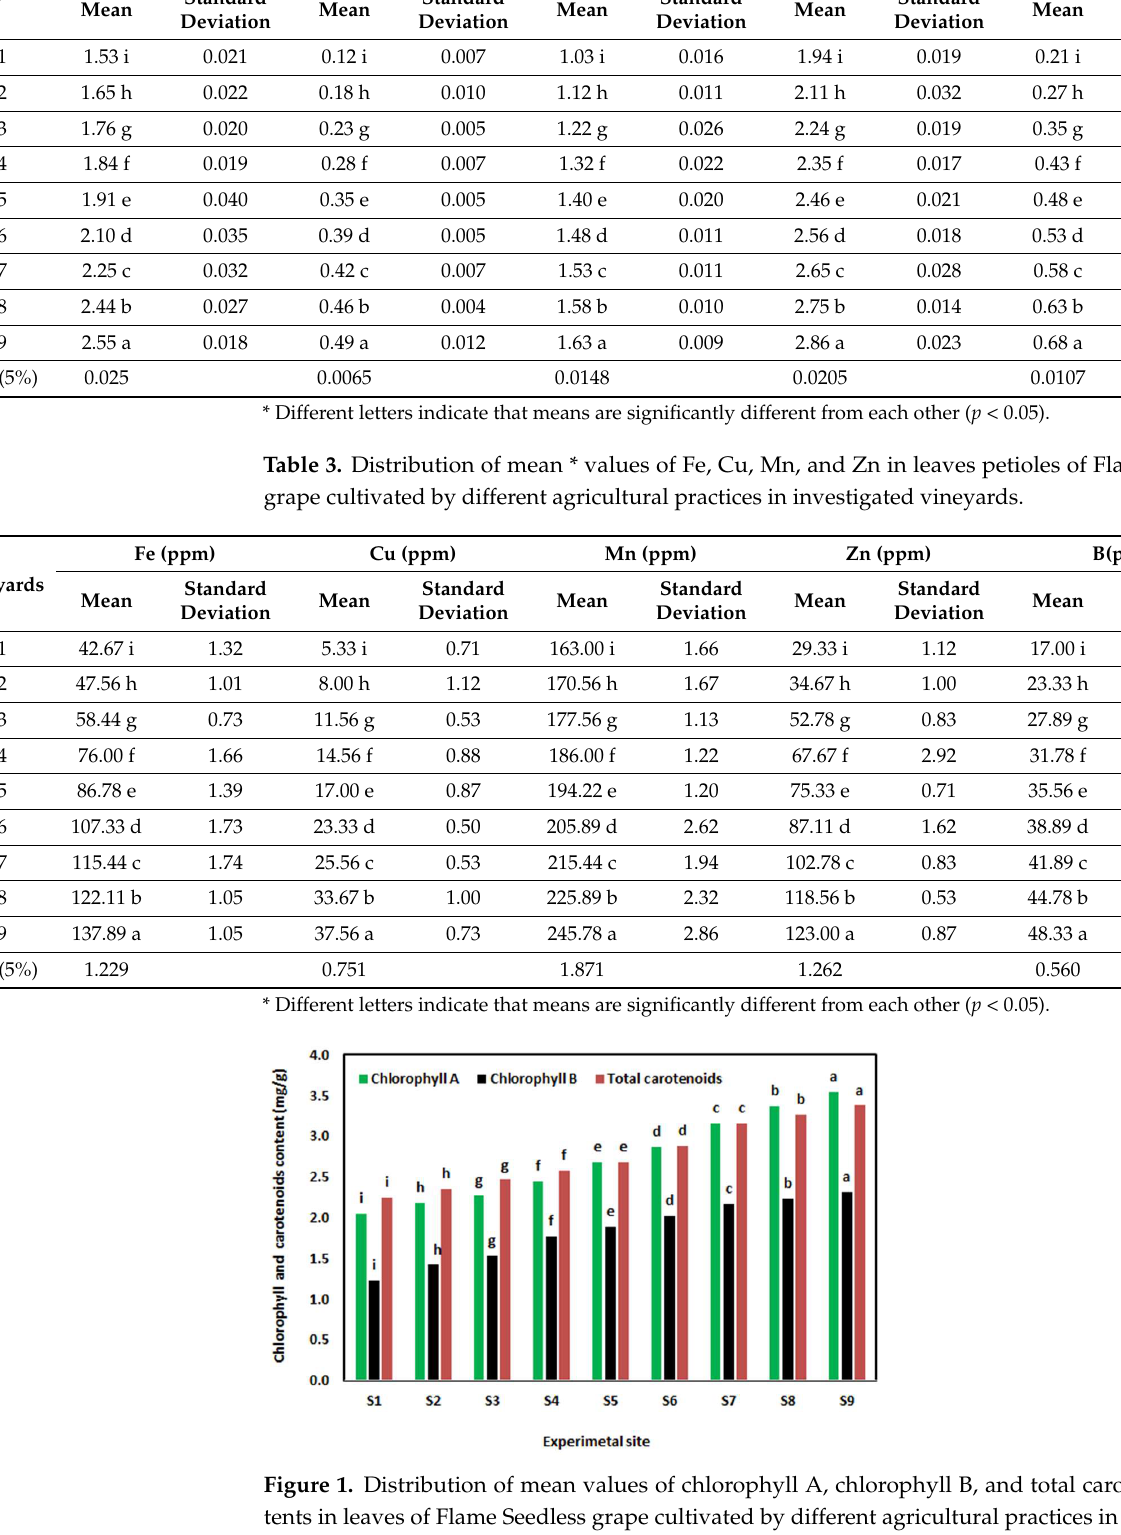
Table 2. Distribution of mean * values of N, P, K, Ca, and Mg in leaves petioles of Flame Seedless grape cultivated by different agricultural practices in investigated vineyards.